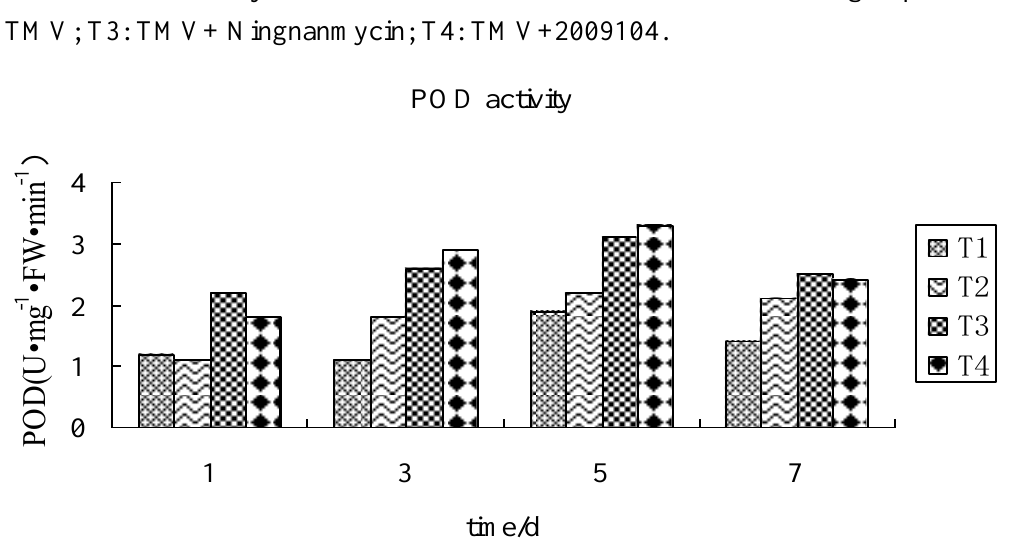
Figure 4. POD activity in tobacco leaves in differential treatment groups T1: